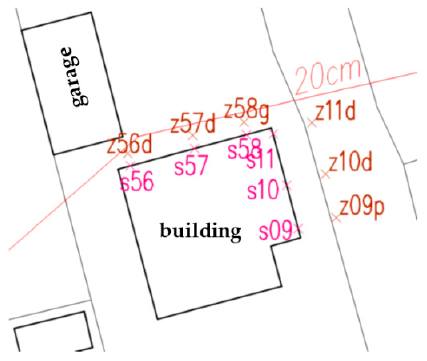
Figure 3. Location of the measuring points in a ground (a brown color) and on a building (a pink color) and a discontinuous linear deformation (a red